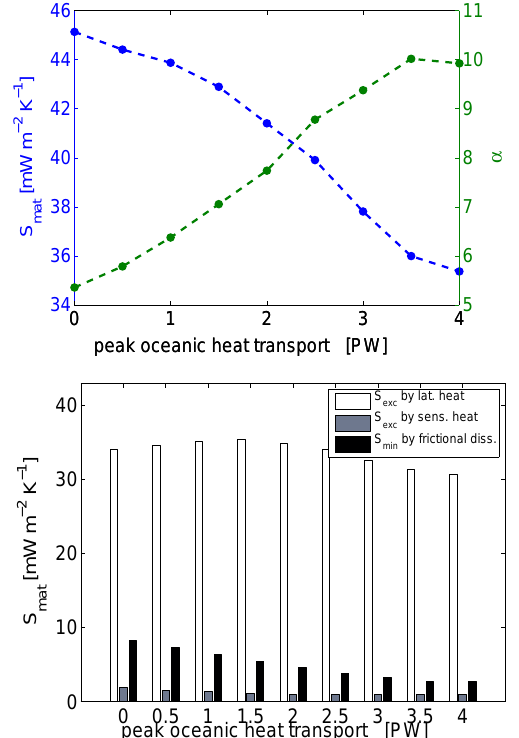
Figure 9. Upper panel: steady-state global mean material entropy production ˙ S mat (blue graph) and degree of irreversibility α . Lower panel: most relevant contributions of ˙ S mat split into ˙ S exc and ˙ S min , as a function of increasing oceanic heat